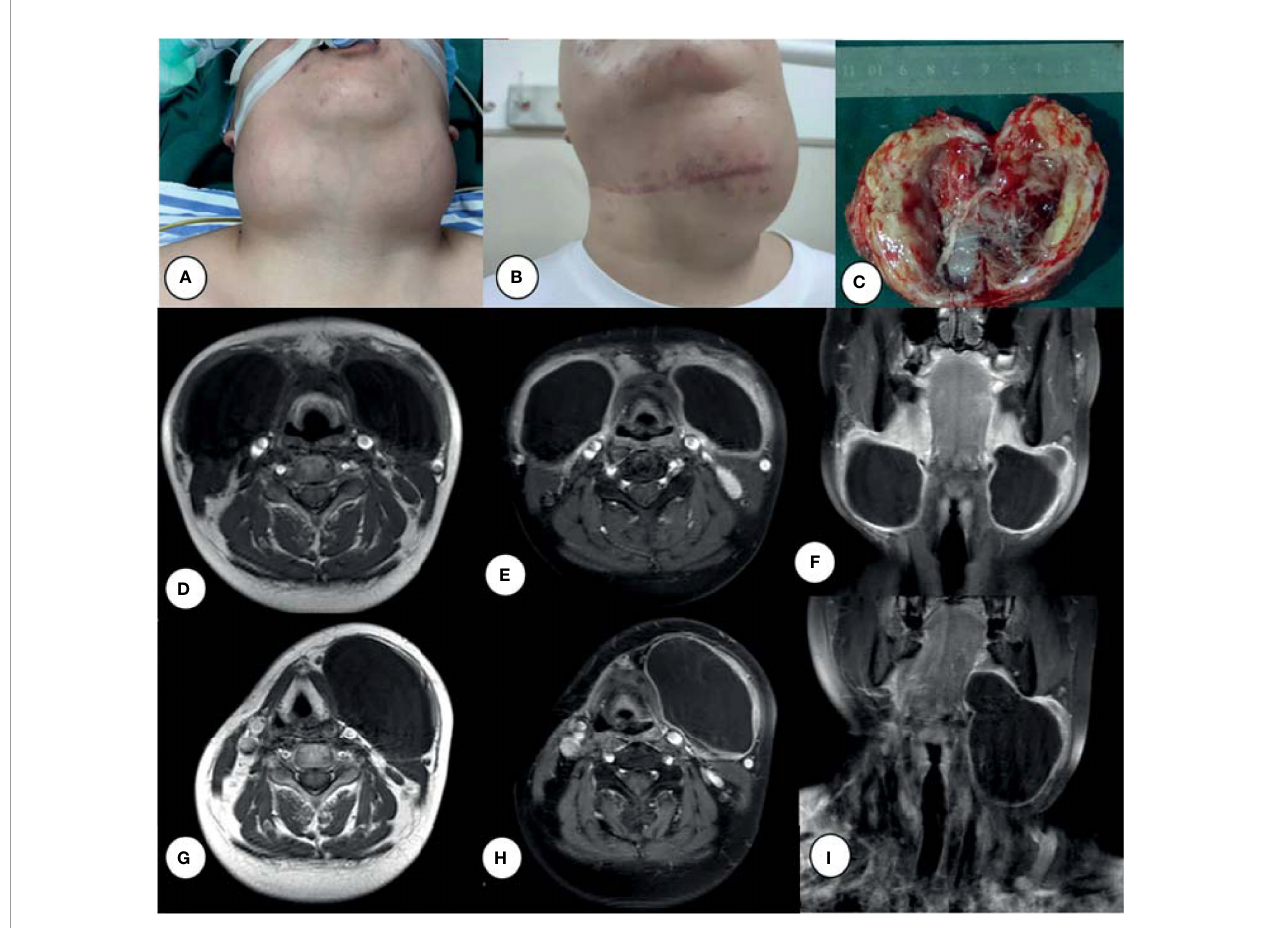
FIGURE 1 | Bilateral cervical giant cysts (A) , left cyst enlarged after chemotherapy (B) , and surgical excision of the right neck mass (C) . MRI of a tumor before surgery (D – F) and after (G – I) chemotherapy: T1-weighted images (D, G) , Ga-enhanced T1-weighted images (E, F, H, I)